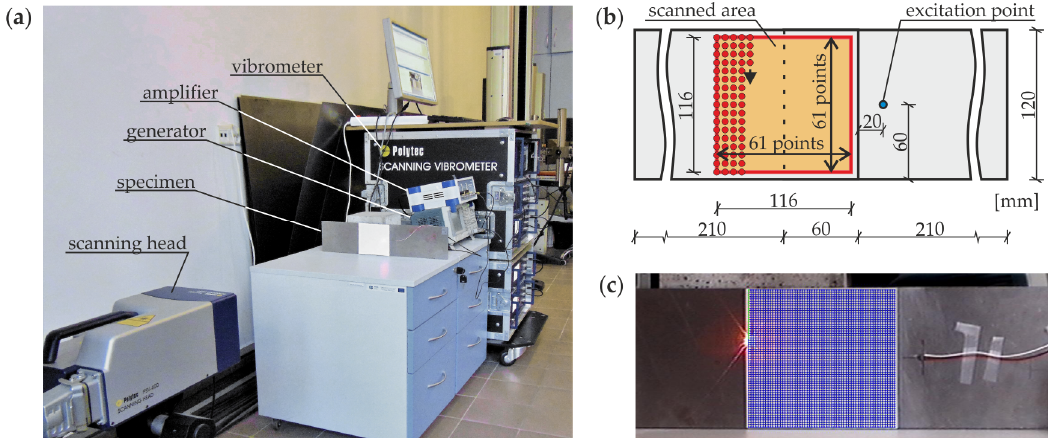
Figure 4. Experimental measurements: ( a ) experimental setup for the generation and acquisition of Lamb waves; ( b ) view of a specimen with the position of a scanned area and excitation point; ( c ) investigated specimen with indicated scanning points.